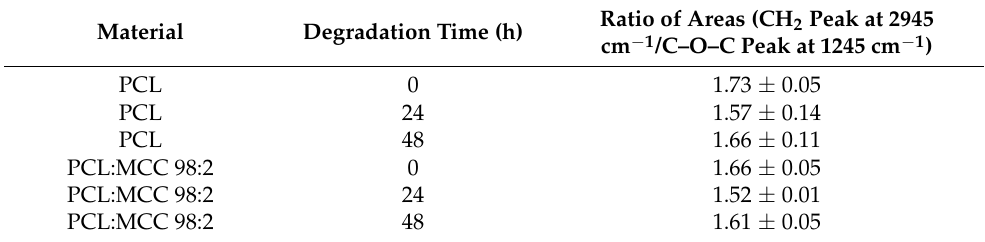
Table 2. Evolution of the FTIR peak areas (CH 2 in the amorphous phase/C–O–C in the crystalline